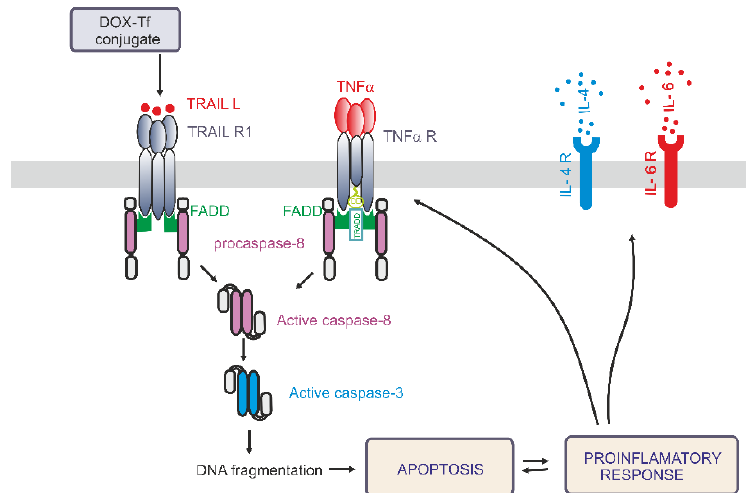
Figure 7. A simplified model of the di ff erential e ff ects of the doxorubicin–transferrin (DOX–Tf) conjugate on the pro-inflammatory response and induction of apoptosis via the extrinsic pathway. DOX–Tf conjugate stimulates the production of TNF- α and TRAIL ligand, the cell signaling proteins. They are also known as two major extrinsic mediators of apoptosis. Acute lymphoblastic cells and chronic myeloid malignancies have di ff erent isoreceptors for these cytokines. Binding of TRAIL or TNF- α to their receptors, results in death receptors aggregation (DR4, DR5) and Fas-associated death domain-containing protein (FADD). The death domain of FADD binds to an analogous domain of caspase-8 to form the death-inducing signaling complex (DISC). This process activates downstream caspases and leads to apoptosis. In parallel, in the presence of typical hallmarks of apoptosis, the DOX–Tf conjugate a ff ects cellular genome and mediates the production of pro-inflammatory response. The transcription of IL-4 and IL-6 genes mediates the secretion of these cytokines to the extracellular